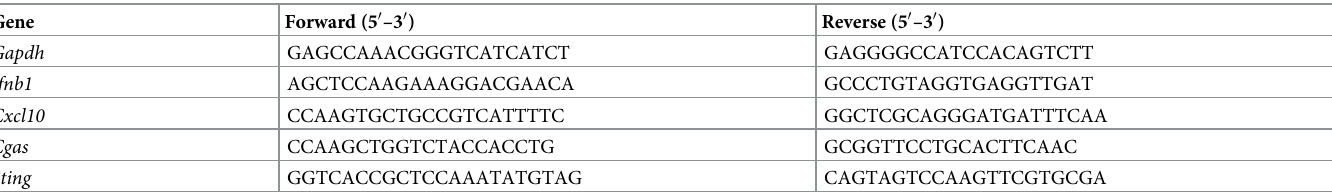
Table 1. Primer sequences used in qRT-PCR